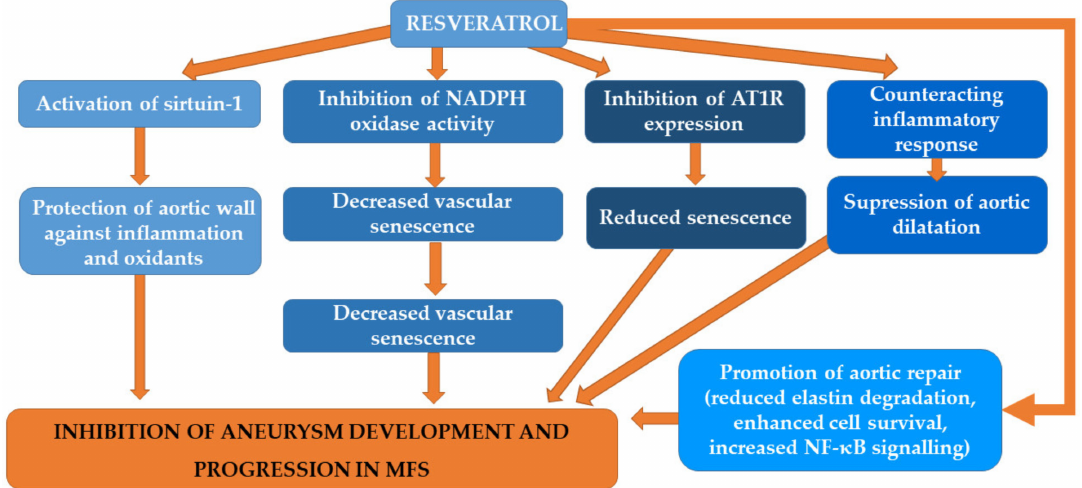
Figure 1. Possible mechanisms underlying the beneficial effects of resveratrol on an aortic aneurysm in